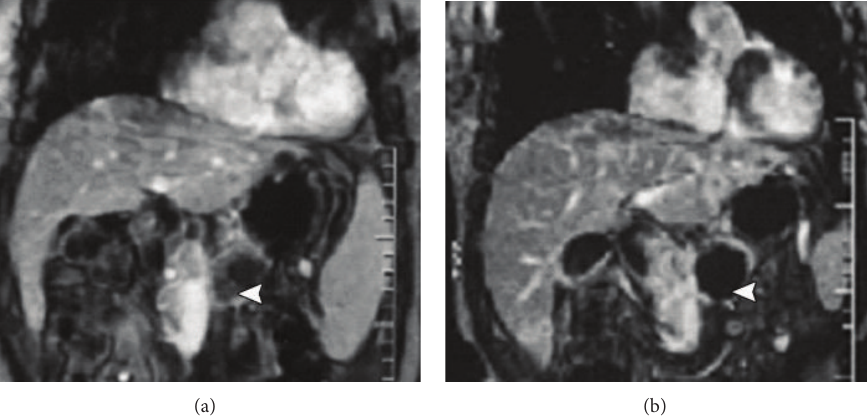
Figure 6: Dynamic contrast-enhanced gradient-echo T1-weighted MR images (a) before and (b) 2 weeks after HIFU ablation for advanced pancreatic cancer with a diameter of 4.5 cm. No evidence of contrast enhancement in the treated lesion (arrowhead) illustrates complete coagulation necrosis (used with permission [19]).